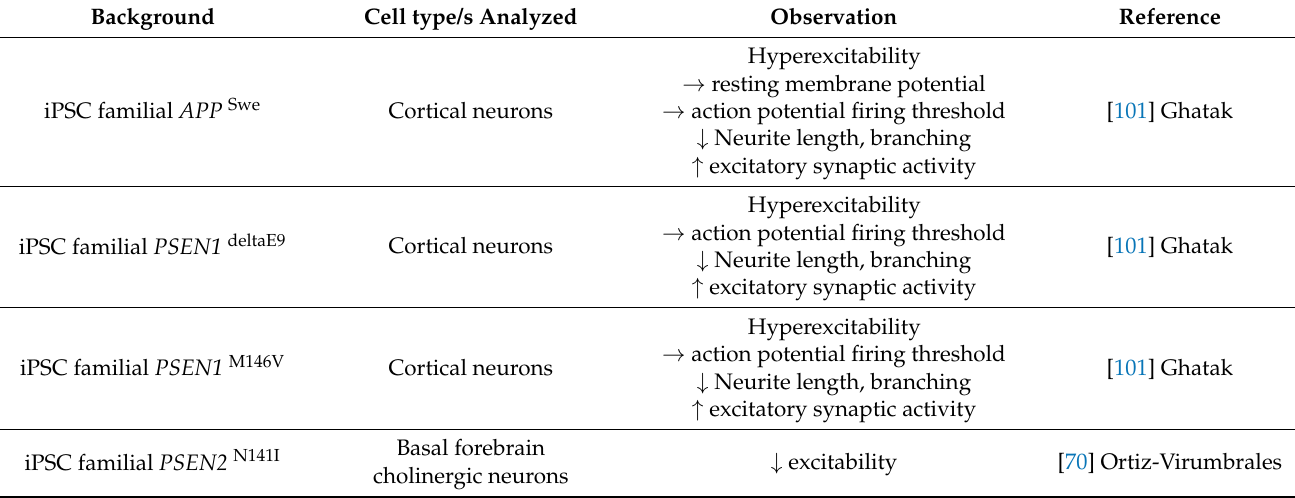
Table 4. Overview of neuronal dysfunction identified in AD-iPSC neurons harboring either familial mutations, sporadic mutations, or from late-onset sporadic AD patients.